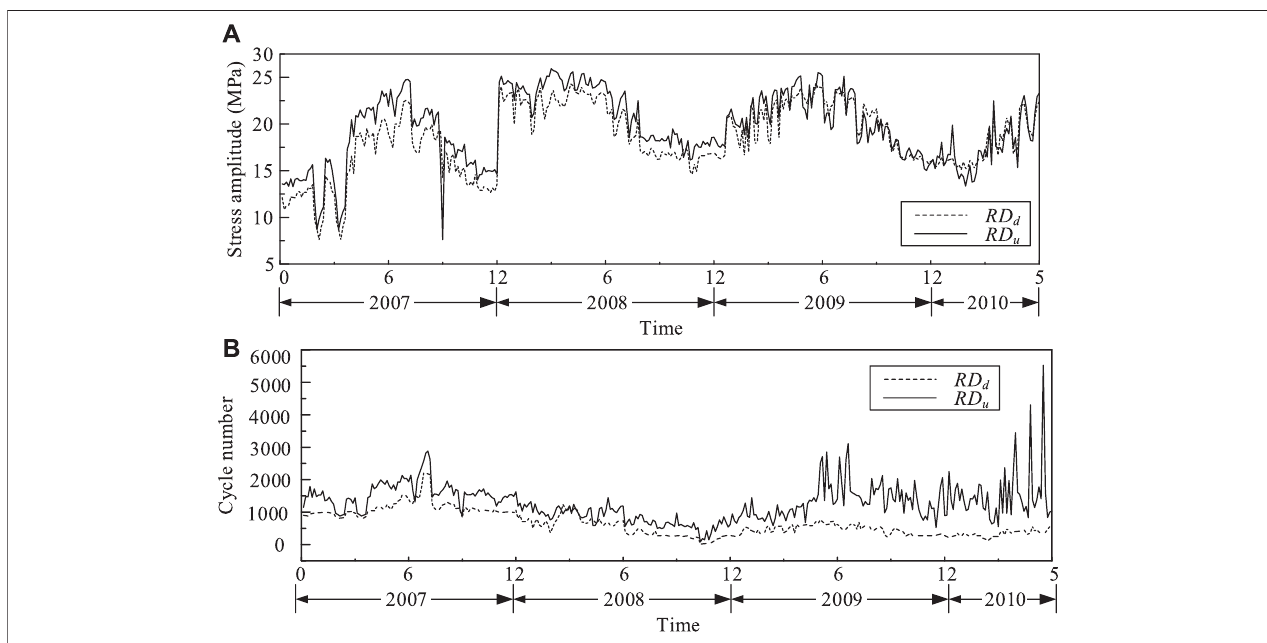
FIGURE 5 | The daily equivalent stress amplitude and cycle number: (A) Daily equivalent stress amplitude, (B) Daily equivalent cycle number.